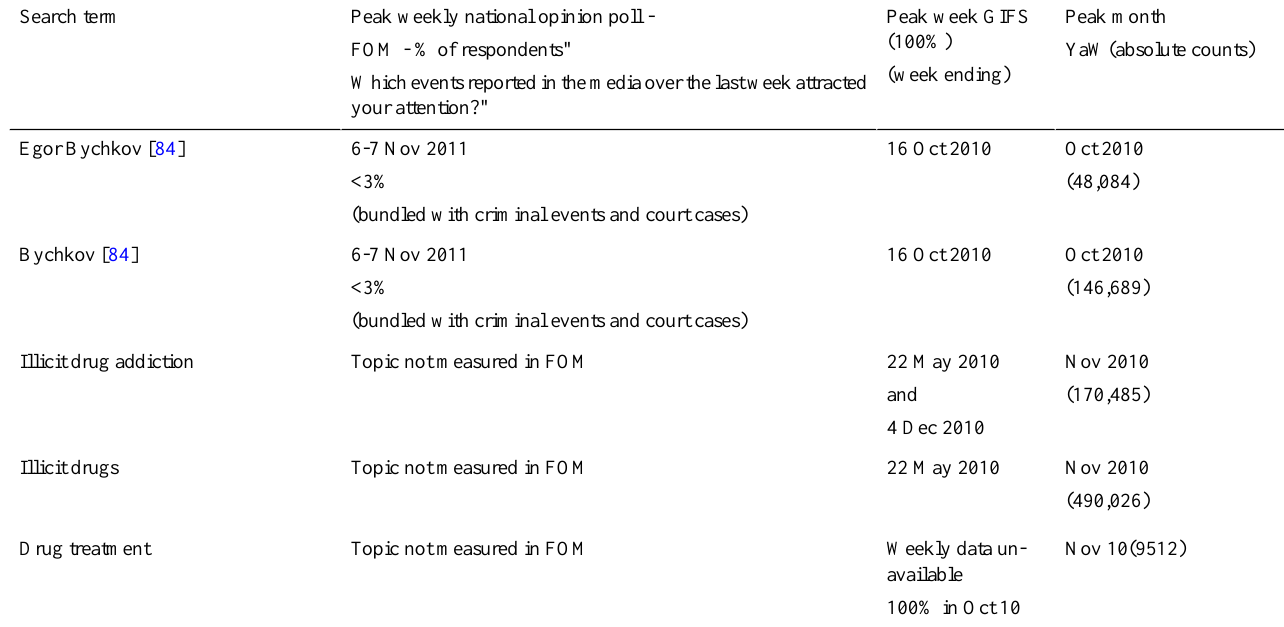
Table 4. Peak interest in the Bychkov episode based on Public Opinion Foundation (FOM) GIFS and YaW during